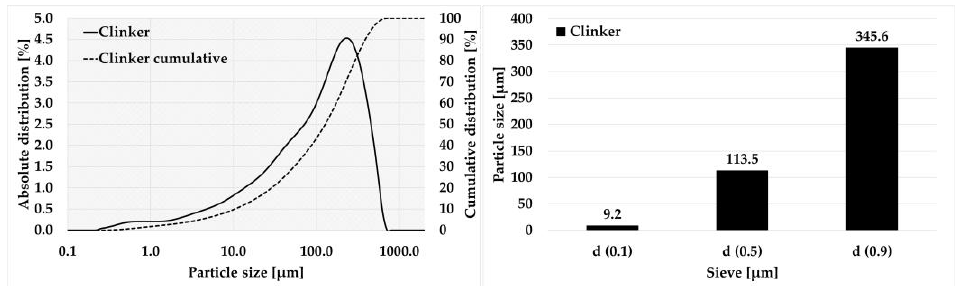
Figure 8. Laser granulometry of clinker (THD method).